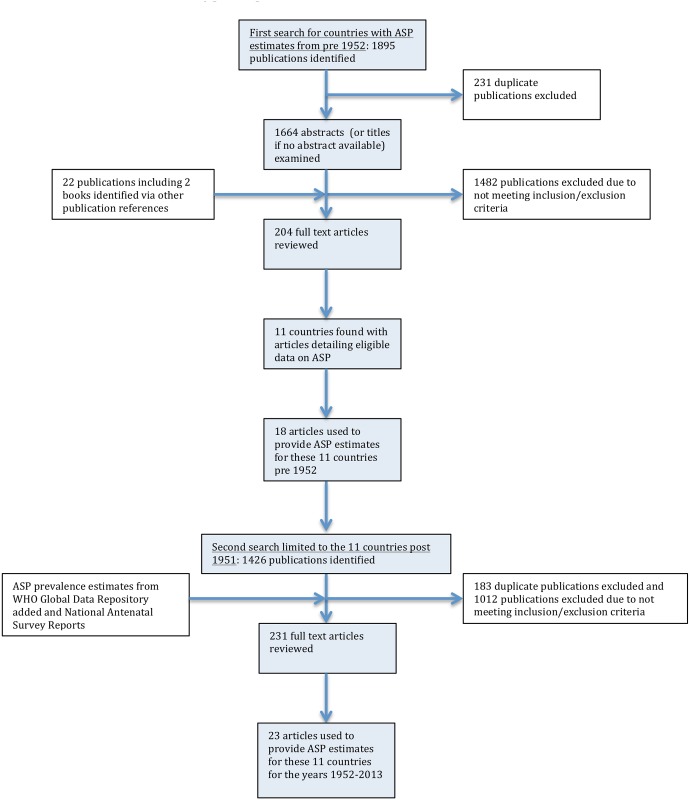
Flow chart showing selection of publications from the literature search for antenatal syphilis prevalence estimates.